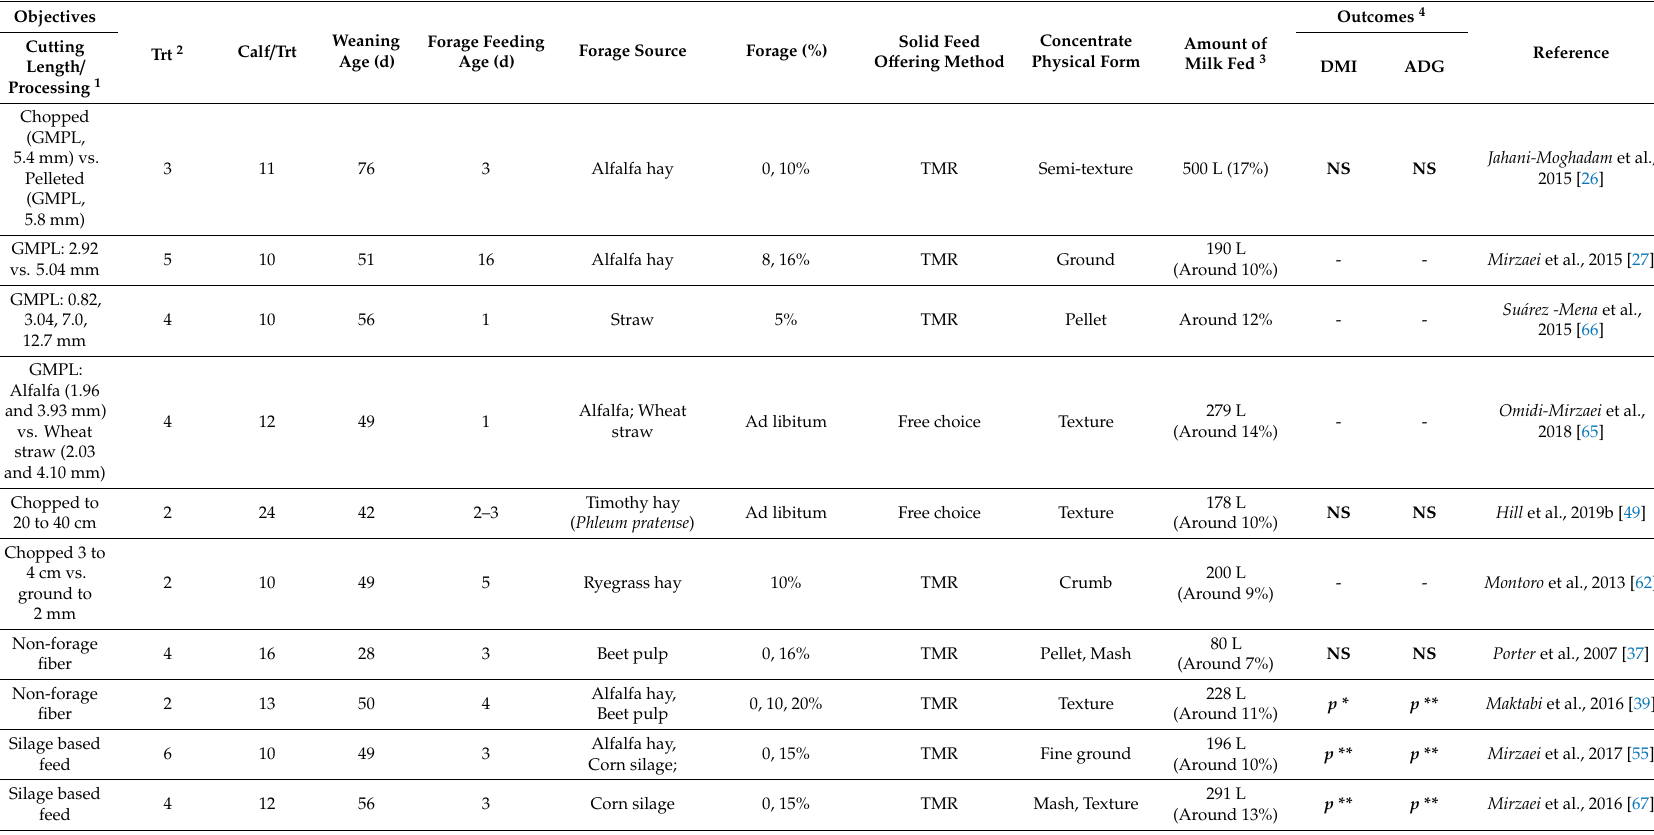
Table 3. A summary of studies related to forage particle size and methods of processing forage in pre-weaned dairy